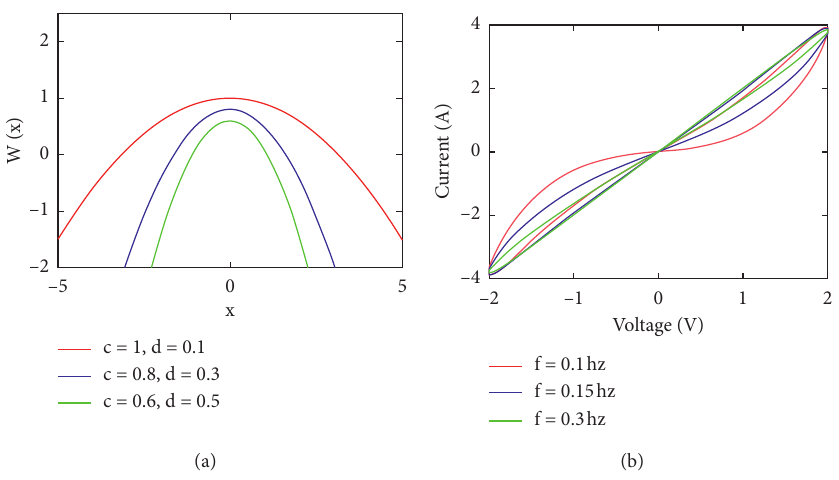
Figure 1: The memductance and pinched hysteresis loop.